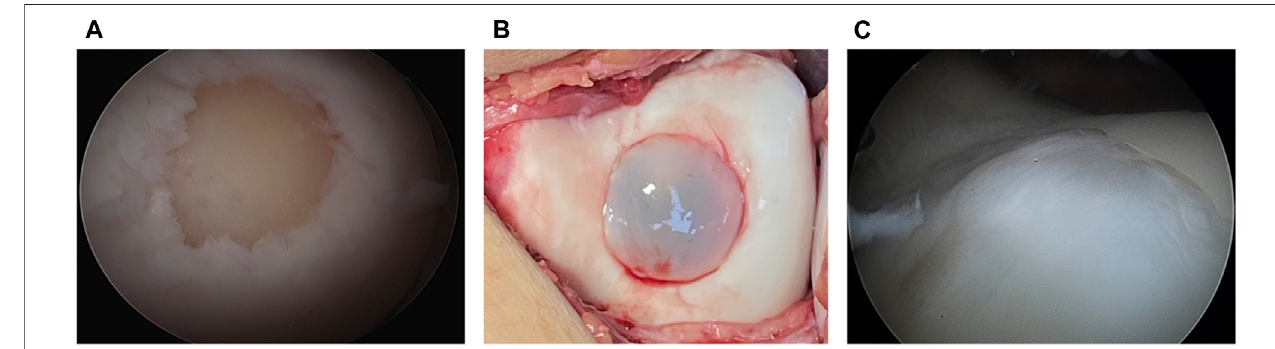
FIGURE 6 | Arthroscopic fi ndings (A) arthroscopic outcome before implantation (B) the implant is transplanted in the lesion (C) a second-look arthroscopy at 12 months. The lesion is covered with cartilage-like tissue after the matrix-associated autologous chondrocyte transplant.